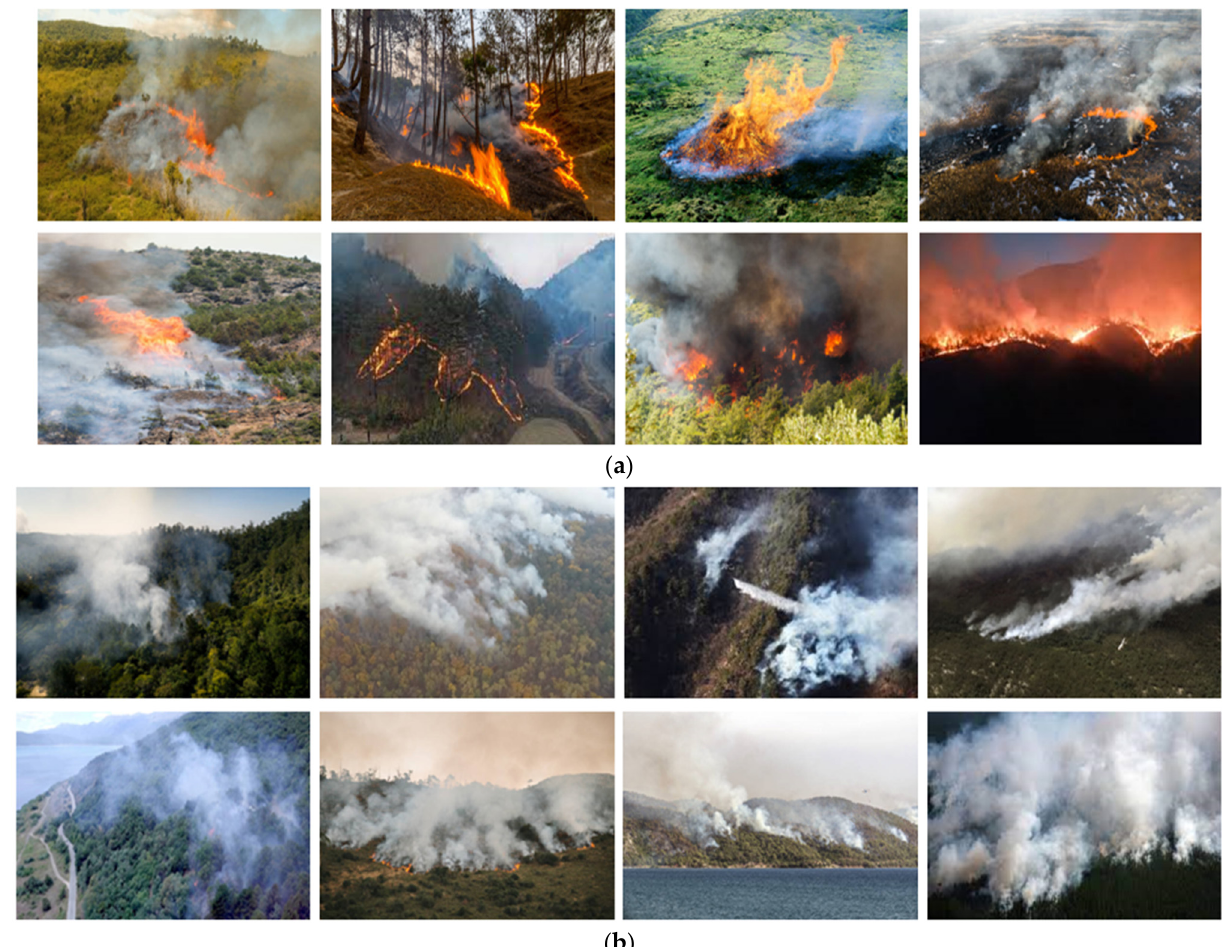
Figure 2. Description of wildfire datasets: ( a ) forest fire; ( b ) forest smoke.